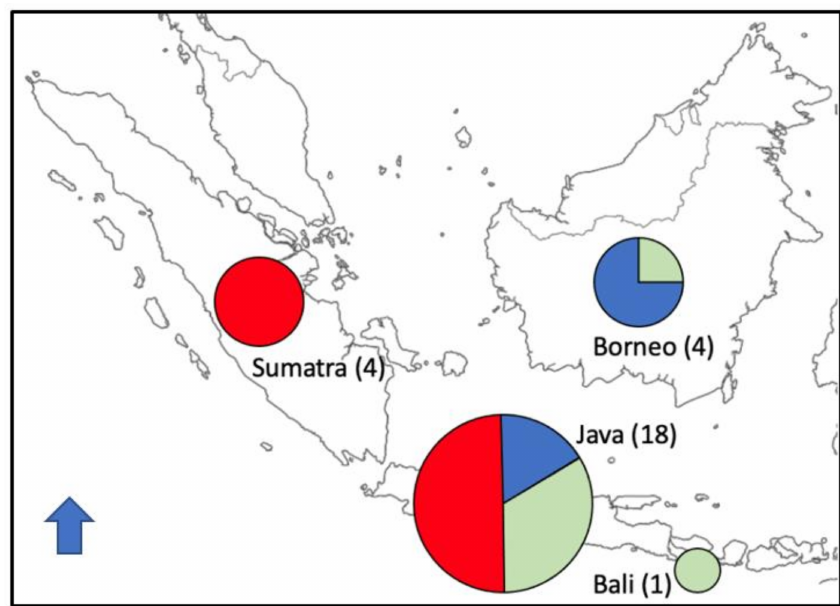
Figure 3. Geographic patterns of apes for sale on Facebook and Instagram in Indonesia, depicting the island where the trader is based and the island where the gibbon or orangutan is found, show-ing that traders on Sumatra only sell Sumatran species (illustrated in red) and Bornean traders sell mainly Bornean species (illustrated in blue), but traders on Java (species illustrated in green) offer species from all three islands for